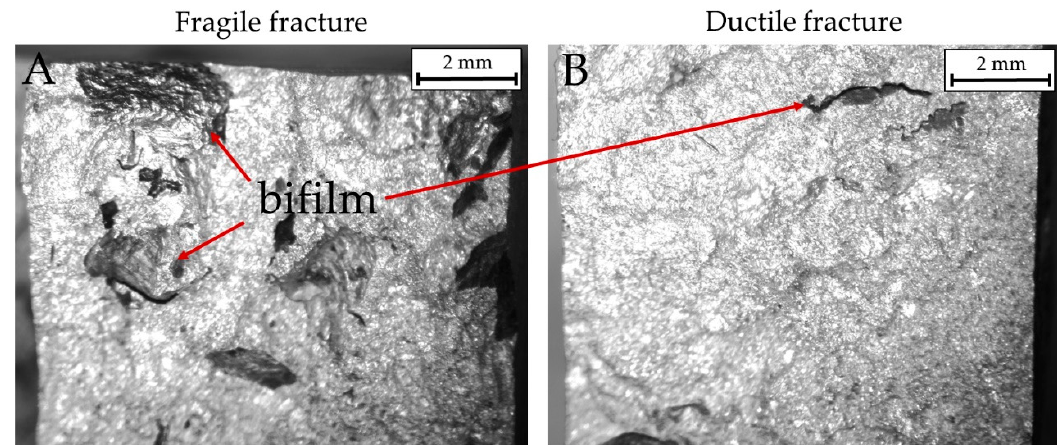
Figure 10. Macrographic images of fractured surfaces in impact specimens. ( A ): A brittle fracture in alloy 4 modified (im- pact energy 3.17 J). ( B ): A ductile fracture in alloy 3 modified (impact energy 8.82 J).